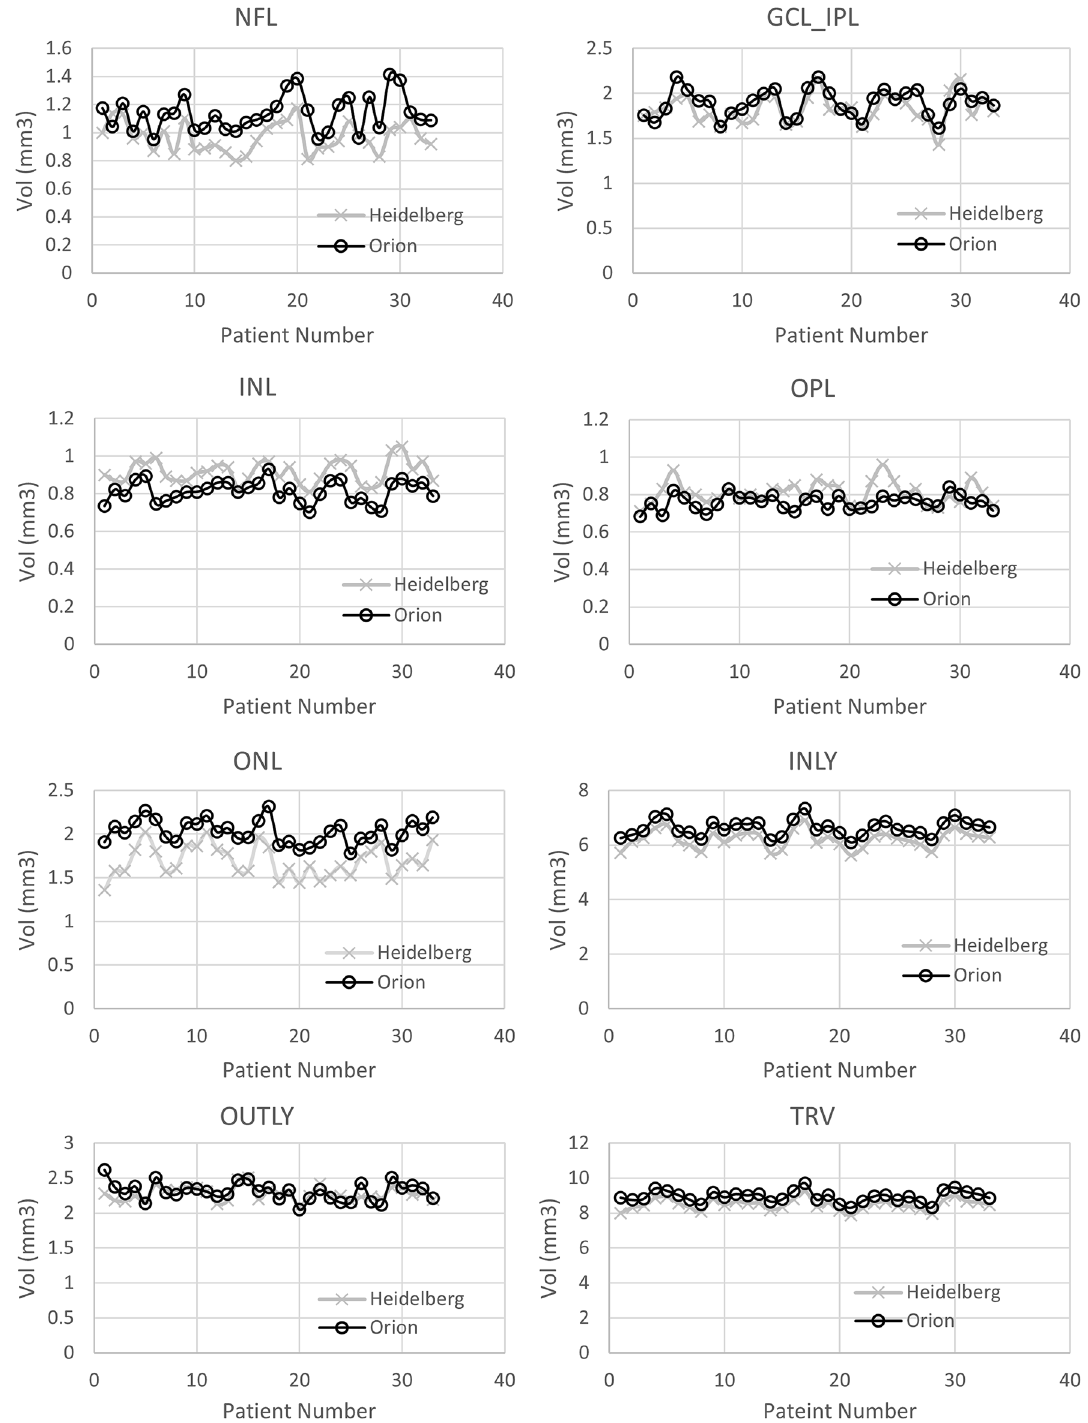
Figure 3. Comparison of retinal layer volumes between proprietary and cross-platform softwares in eyes with